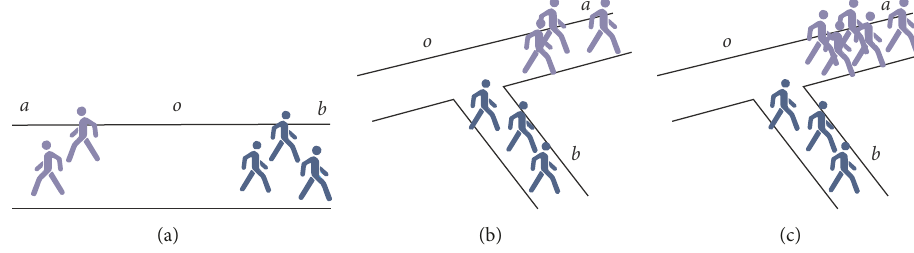
Figure 1: Crowd interpolation in different scenarios. Node 𝑜 is the unsampled site, and nodes 𝑎 and 𝑏 are sampling sites.